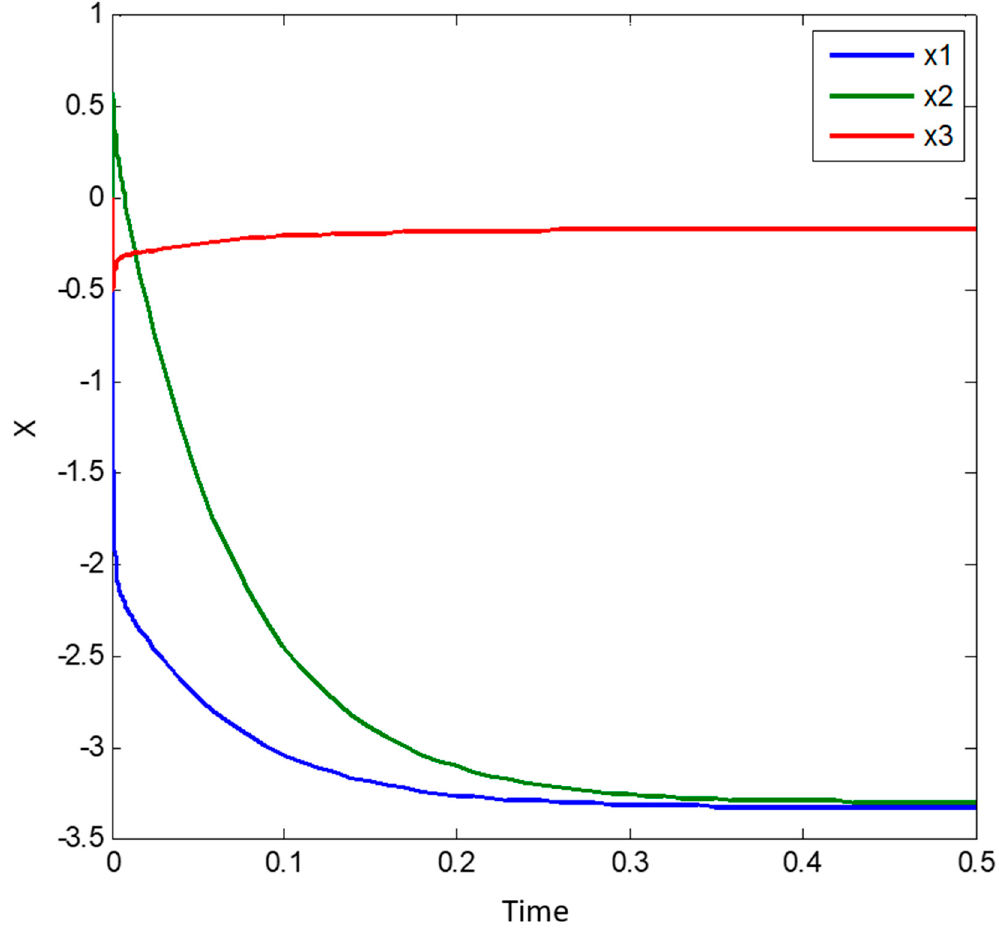
Figure 4. Result of our model simulation for solving the illustrative example with respect to solving an algebraic system of linear equations. Please note in this case we have taken n = 3 in Equation (24) or Equation (31).